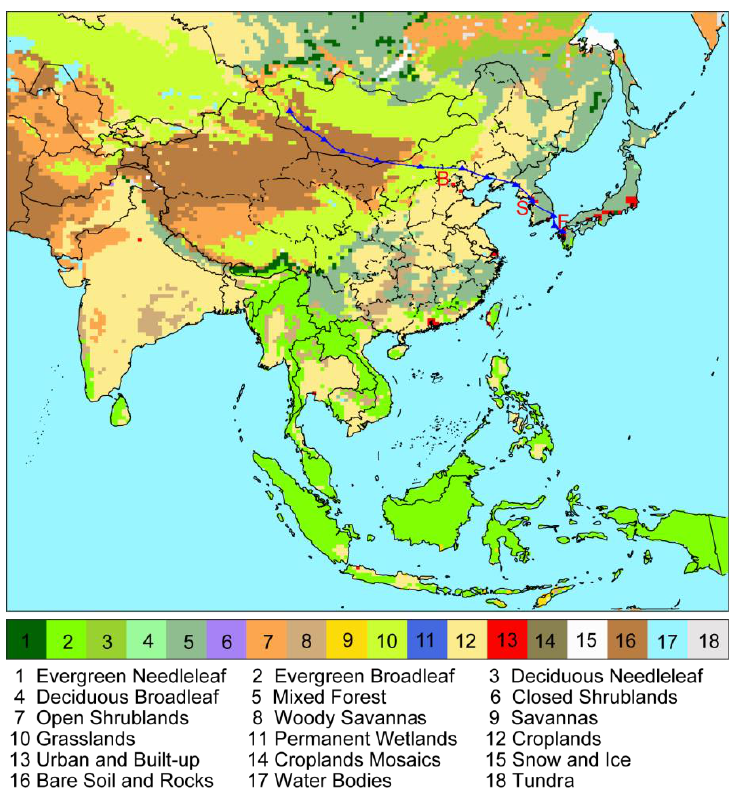
Figure 1. Model domain and land use categories by Moderate Resolution Imaging Spectrometer (MODIS) data. B, S, and F indicate Beijing, Seoul, and Fukuoka. The blue line with triangle markers (every 6 hours) is the 72-h backward trajectory from Fukuoka at 20:00, on 6 May 2017 (JST).